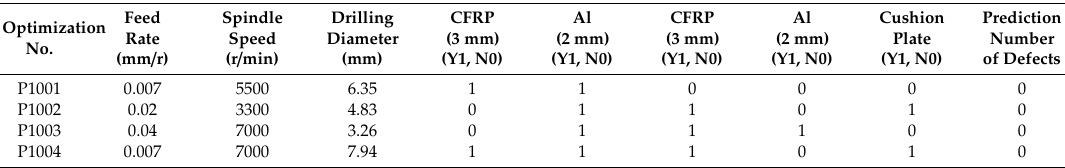
Table 6. Some applied optimization